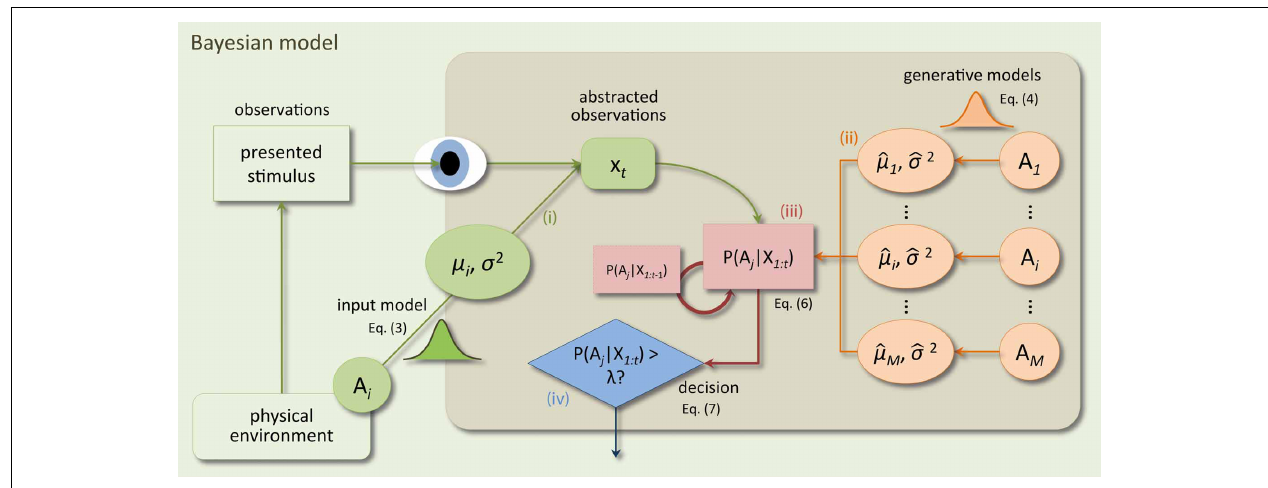
(cid:2) t σ 2 . Bayesian inference (iii) recursively computes posterior μ i and variance beliefs over the correctness of a decision alternative given all